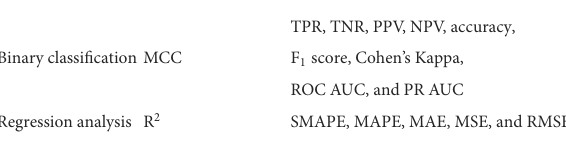
TABLE 1 Recap of the suggested metrics for evaluating results of binary classifications and regression analyses. Analysis type Always include We suggest to